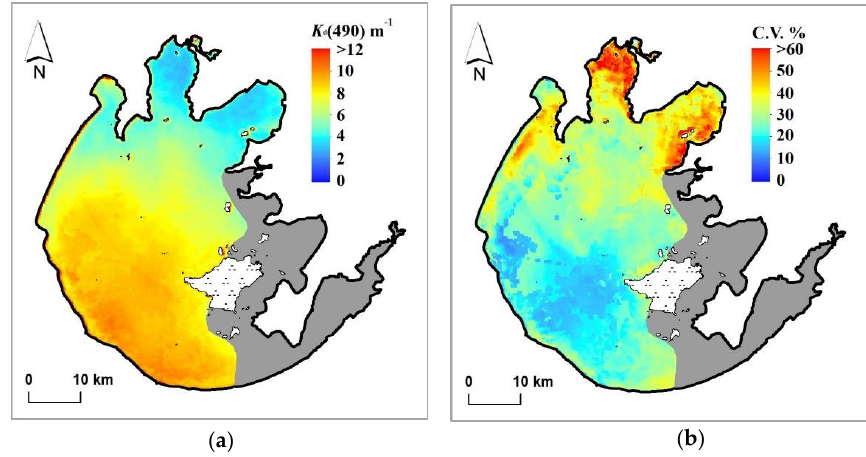
Figure 7. Distributions of ( a ) the mean and ( b ) the coefficient of variation (CV) of the OLCI-derived K d (490) in Lake Taihu from November 2016 to April 2017.